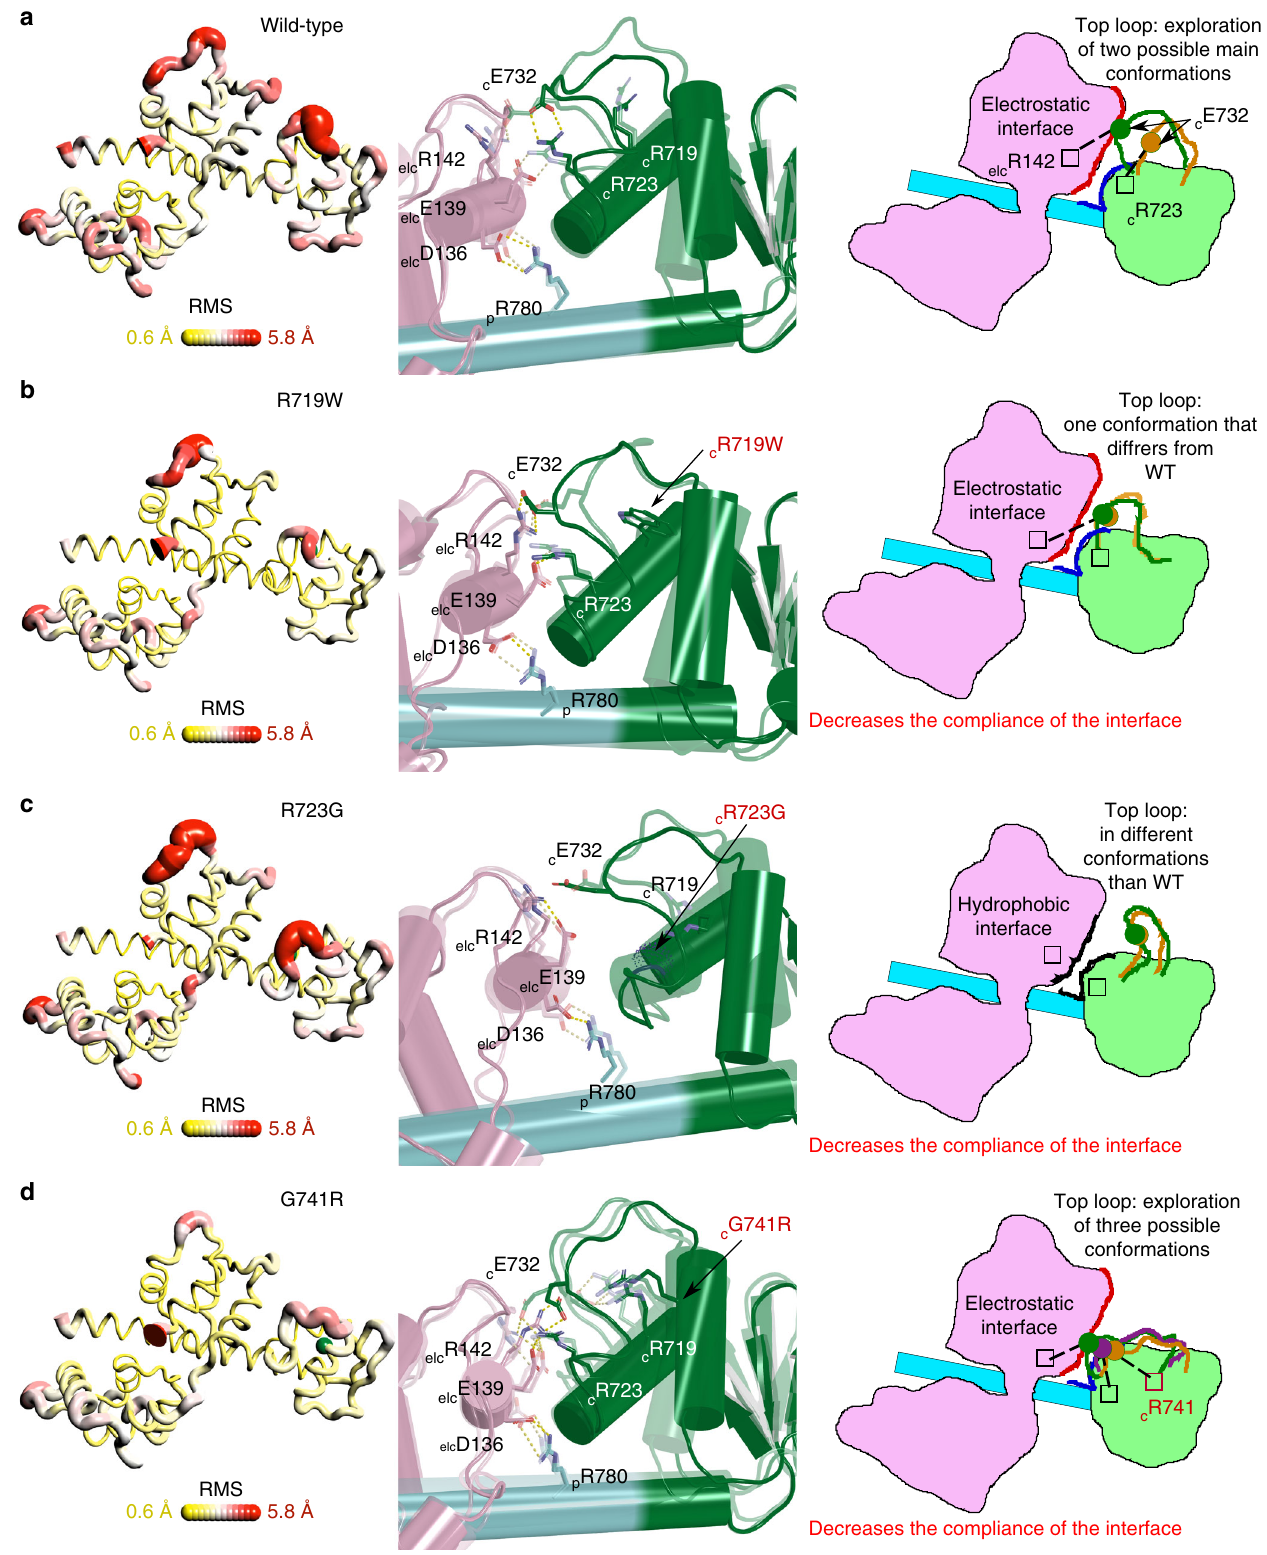
hydrophobic pocket of the BH-U50 in a lock-and-key fashion (Fig. 4b, Supplementary Fig. 6E), (ii) polar and charged residues from the FH-converter, including R719 (converter) and R739 (top loop), create an extended network with the BH-U50 (Fig.